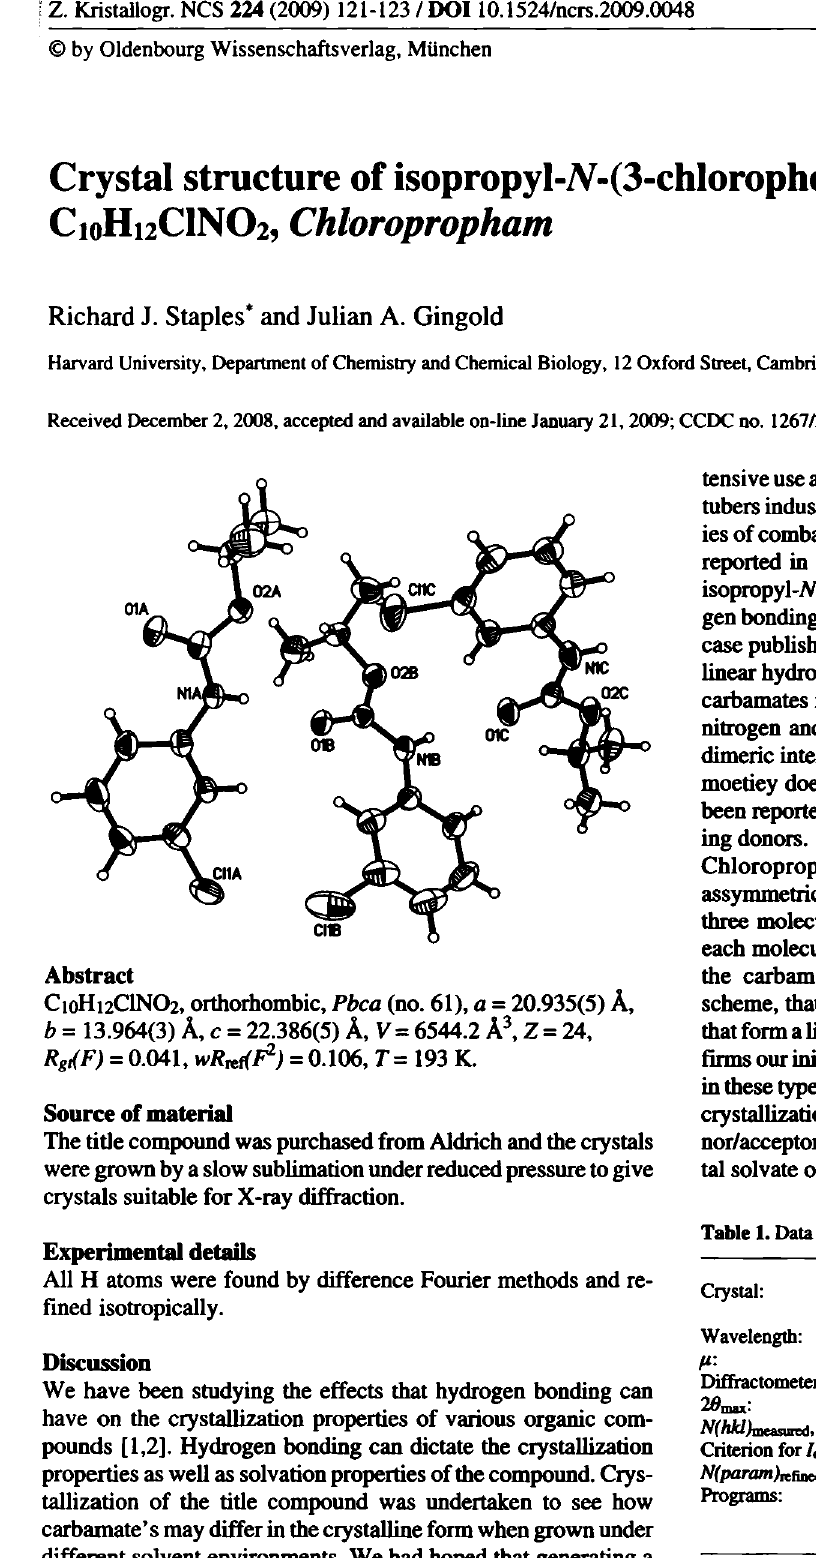
Table 1. Data collection and handling.